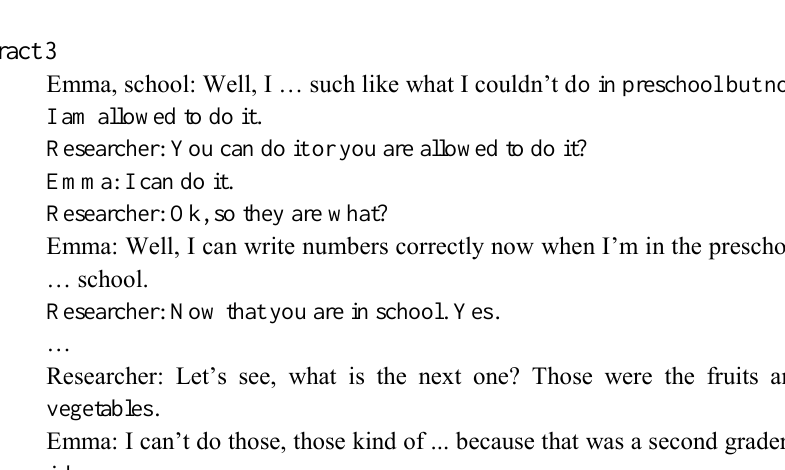
Figure 3. At school I can write numbers